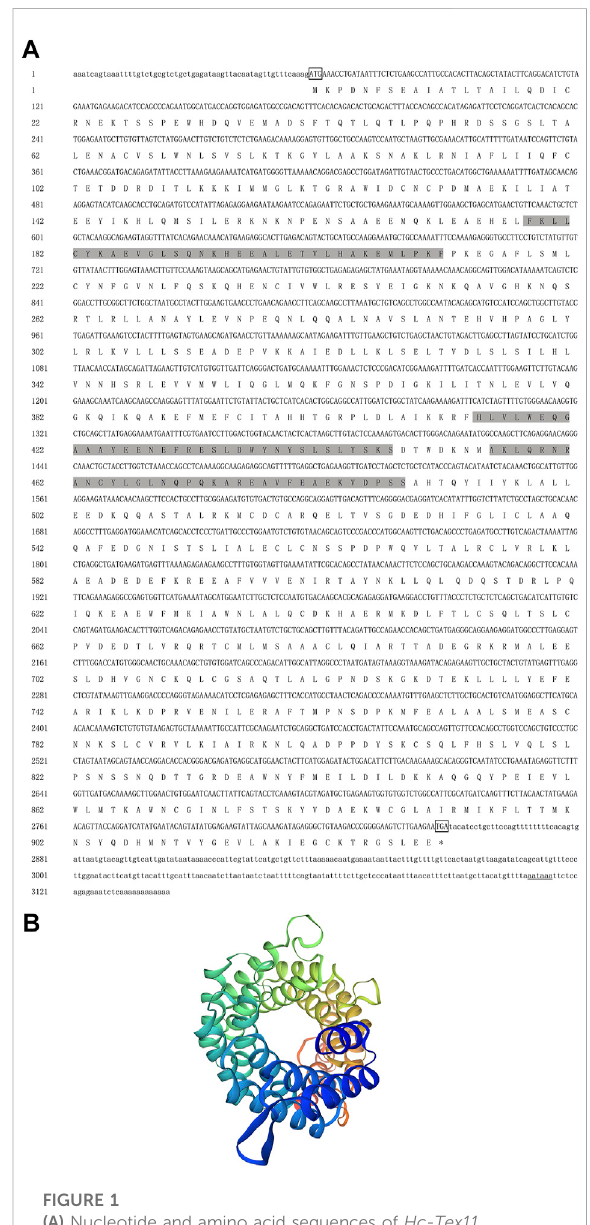
FIGURE 1 (A) Nucleotide and amino acid sequences of